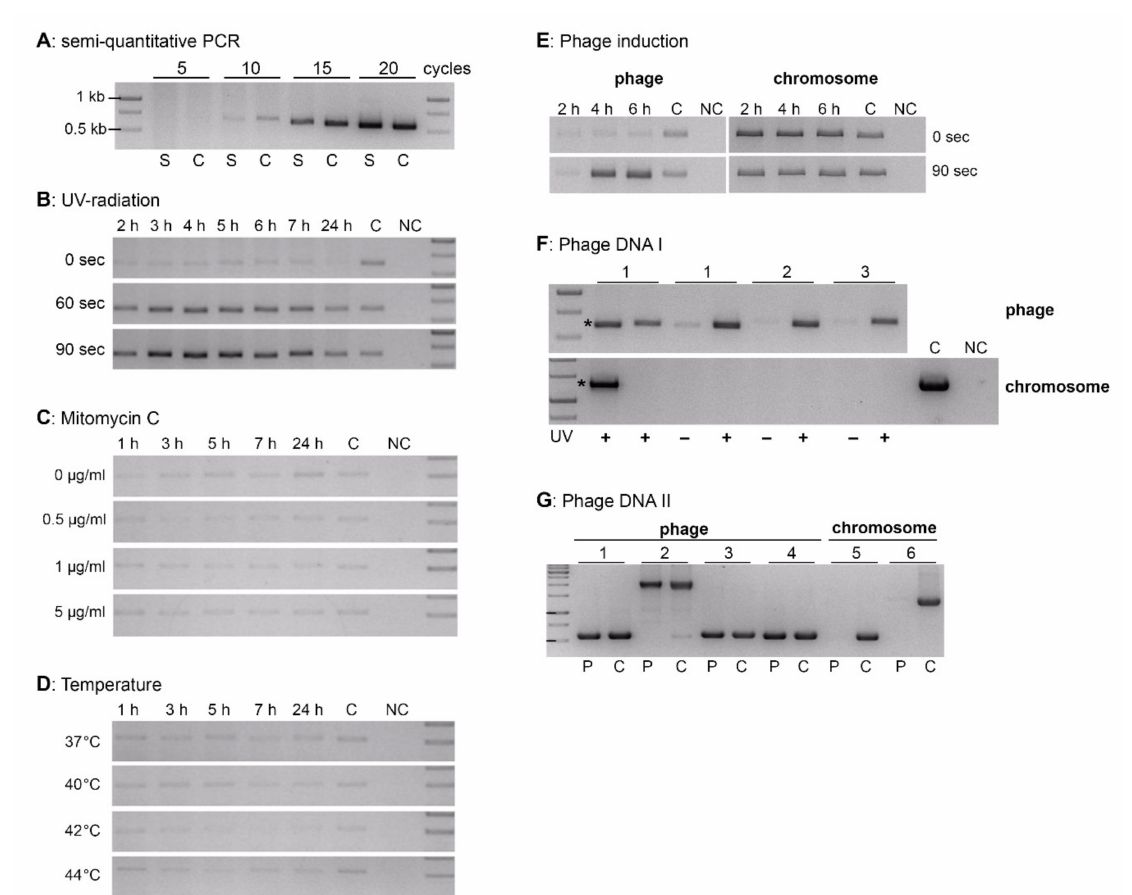
Figure 4. Bacteriophage induction. ( A ): Semi-quantitative PCR analyses. Supernatants of Fhi 3523 lysates (S) and control DNA of Fhi 3523 (C) were analyzed using primer Fha-2/Fha-3 (product size: 538 bp) with 5, 10, 15 and 20 PCR amplification cycles. ( B – D ): Fhi 3523 was exposed to UV radiation at 254 nm for 0, 60 and 90 s ( B ); treated with 0, 0.5, 1 and 5 µ g/mL mitomycin C ( C ); or incubated at 37, 40, 42 and 44 ◦ C ( D ). Samples were collected after various time points post-induction and used for PCR analyses with Fha-2/Fha-3 and 10 amplification PCR cycles. ( E ): PCR analyses were performed targeting the phage KIRK using primers Fha-2/Fha-3 (left, 538 bp) and bacterial genome of Fhi 3523 with primers Fhis_R13/Fhis_U13A (right, 1289 bp) after 0 and 90 s of UV radiation (254 nm) at different time points. ( F ): Supernatants (1, 2, 3, three replicates) of Fhi 3523 cultures treated with (+) or without ( − ) UV for 90 s at 254 nm were analyzed by PCR detecting the phage (Fha-2/Fha-3, 10 PCR cycles, upper row) and the bacterial Fhi 3523 chromosome (Fhis_U13A/Fhis_R13, lower row). All supernatants were treated with DNase and RNase and sterile filtered prior using in PCR analyses, except for sample marked by asterisk (control) which was not treated with DNase and RNase. ( G ): Purified, UV-induced phage samples (P) and control DNA of Fhi 3523 (C) were analyzed targeting FhaGI-1 (PCR 1–4) and chromosomal regions of Fhi 3523 (PCR 5, 6), respectively. 1: Fha-2/Fha-3 (538 bp); 2: Fha996_U/Fha997_R (2024 bp); 3: F1_out_U/F2_out_R (554 bp); 4: F2_out_U/F3_out_R (530 bp); 5: Fha-1/Fha-4 (617 bp); 6: Fhis_R13/Fhis_U13A (1289 bp). C = control DNA of Fhi 3523 (whole DNA of bacterial cell lysates, see Section 2.2); NC = no template control; DNA ladder 1 kb GeneRuler was